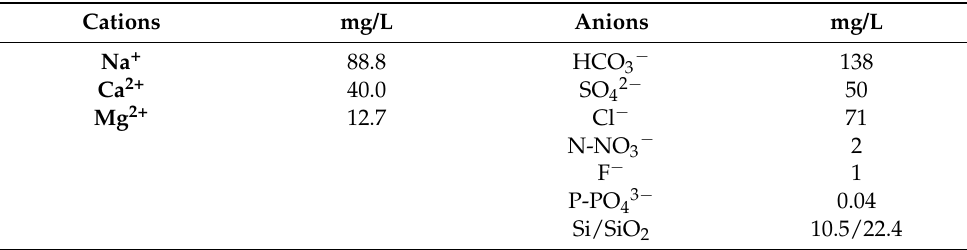
Table 1. Ion concentrations in the NSF water matrix, simulating natural water used for